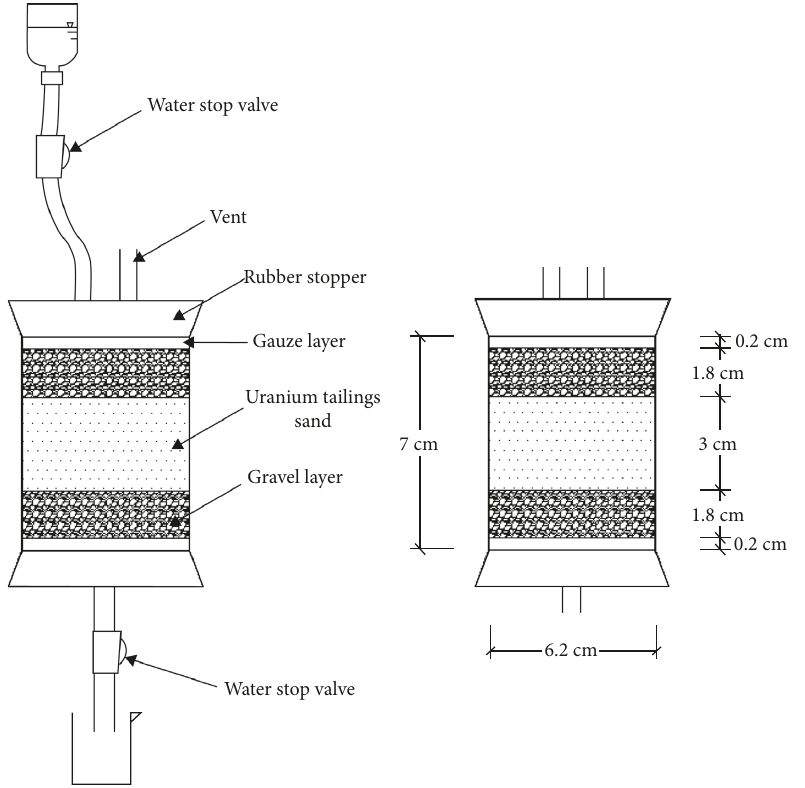
Figure 1: Schematic diagram of the MICP experimental